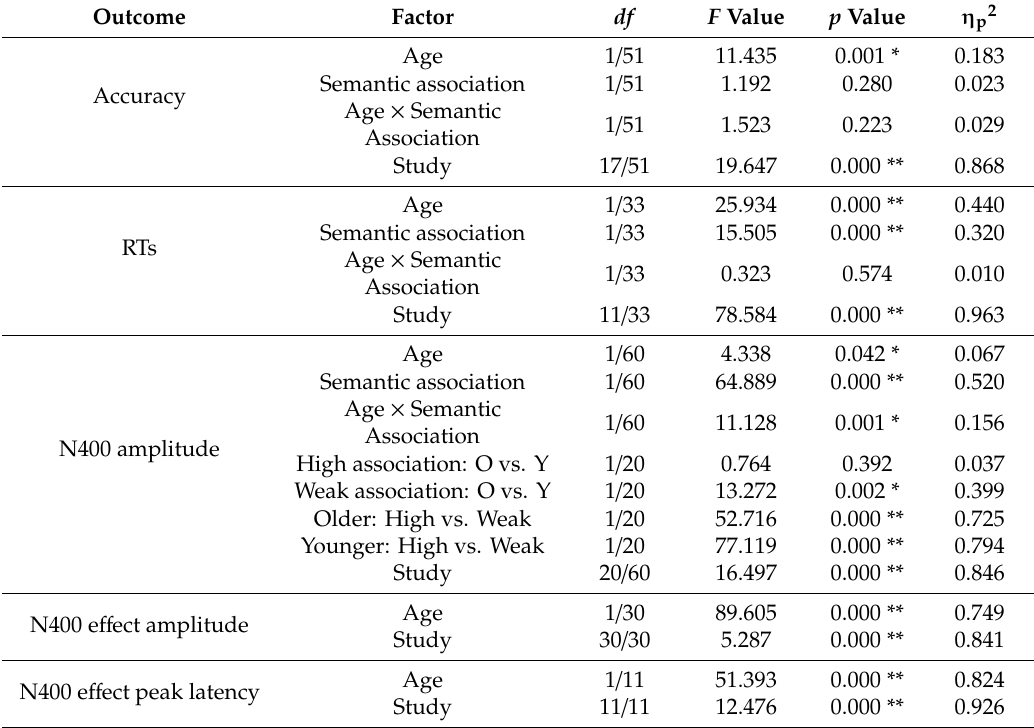
Table 1. Results of univariate ANOVAs and tests of simple e ff ects for comparisons between older and younger healthy